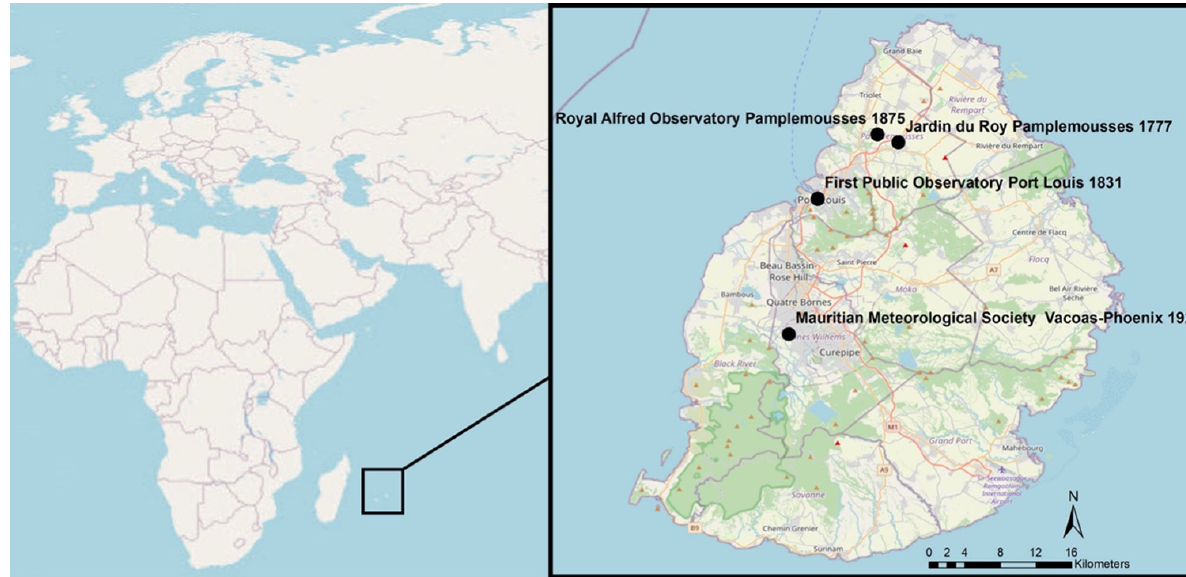
Figure 3. Zoomed-out and zoomed-in imagery from OpenStreetMap (© OpenStreetMap contributors 2021; distributed under the Open Data Commons Open Database License – ODbL – v1.0) showing the position and local geography of Mauritius, including the various locations referred to in the text superposed on the inset map.